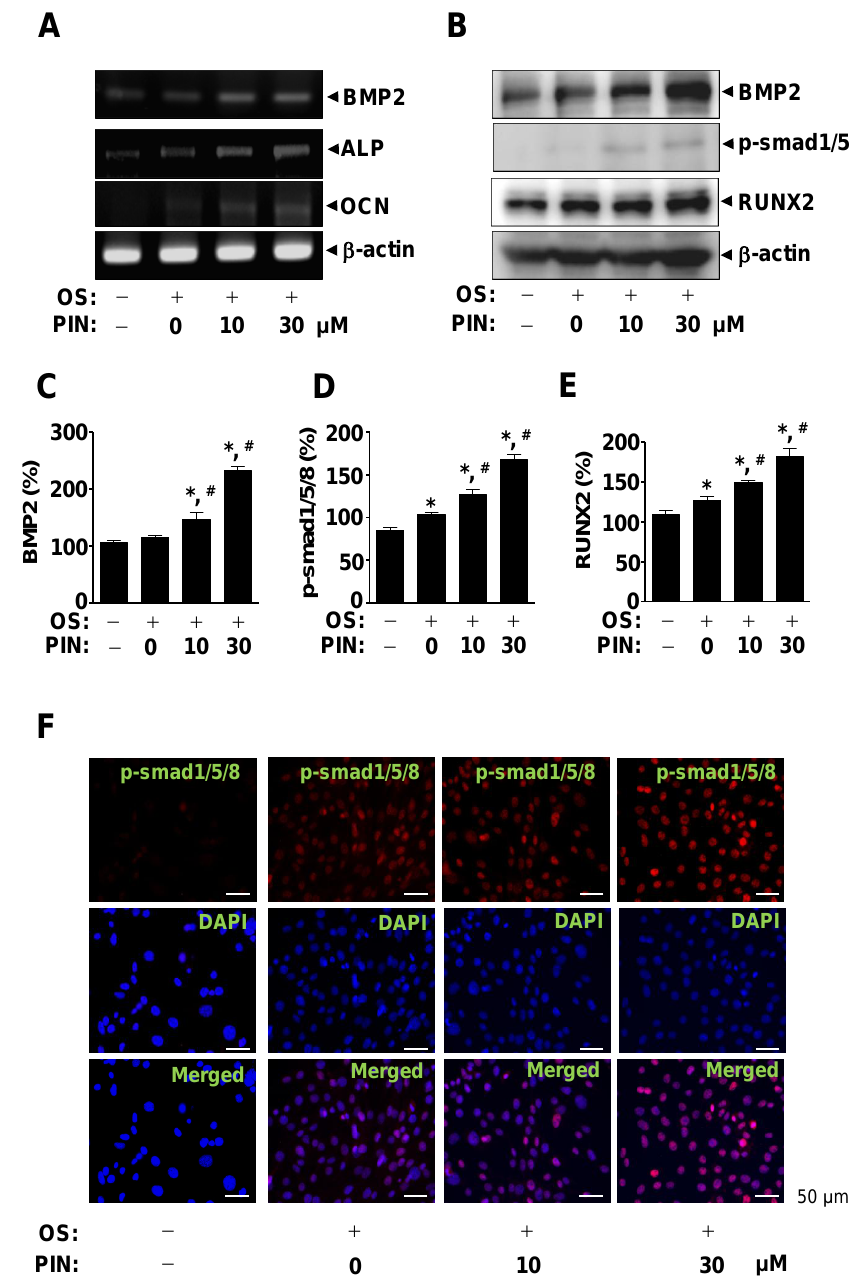
Figure 5. E ff ect of PIN on BMP2 signaling and gene expression during osteoblast di ff erentiation. ( A ) After 10 and 30 µ M PIN was treated for 3 days in osteoblast di ff erentiation, total RNA was isolated. The mRNA levels of BMP2, ALP, OCN, and β -actin were analyzed by using RT-PCR. β -actin was used as a loading control. ( B – E ) After 24 h, the protein levels of BMP2, p-Smad1 / 5 / 8, RUNX2, and β -actin were assessed using western blot analysis. β -actin was used as a loading control (B). The levels of BMP2 ( C ), p-Smad1 / 5 / 8 ( D ), and RUNX2 ( E ) were represented as relative percentages of the control and exhibited as a bar graph. ( F ) After 24 h, p-smad1 / 5 / 8 was immunostained with rabbit anti-p-smad1 / 5 / 8 antibody, followed by Alexa-Fluor 568-conjugated secondary antibody (red) and counterstained with DAPI (blue). The bottom panels show the merged images of the up and middle panels. Scale bar: 50 µ m Data represent the mean ± S.E.M. of experiments. *, p < 0.05 indicates statistically significant di ff erence, compared with the control. #, p < 0.05 indicates statistically significant di ff erence when compared with